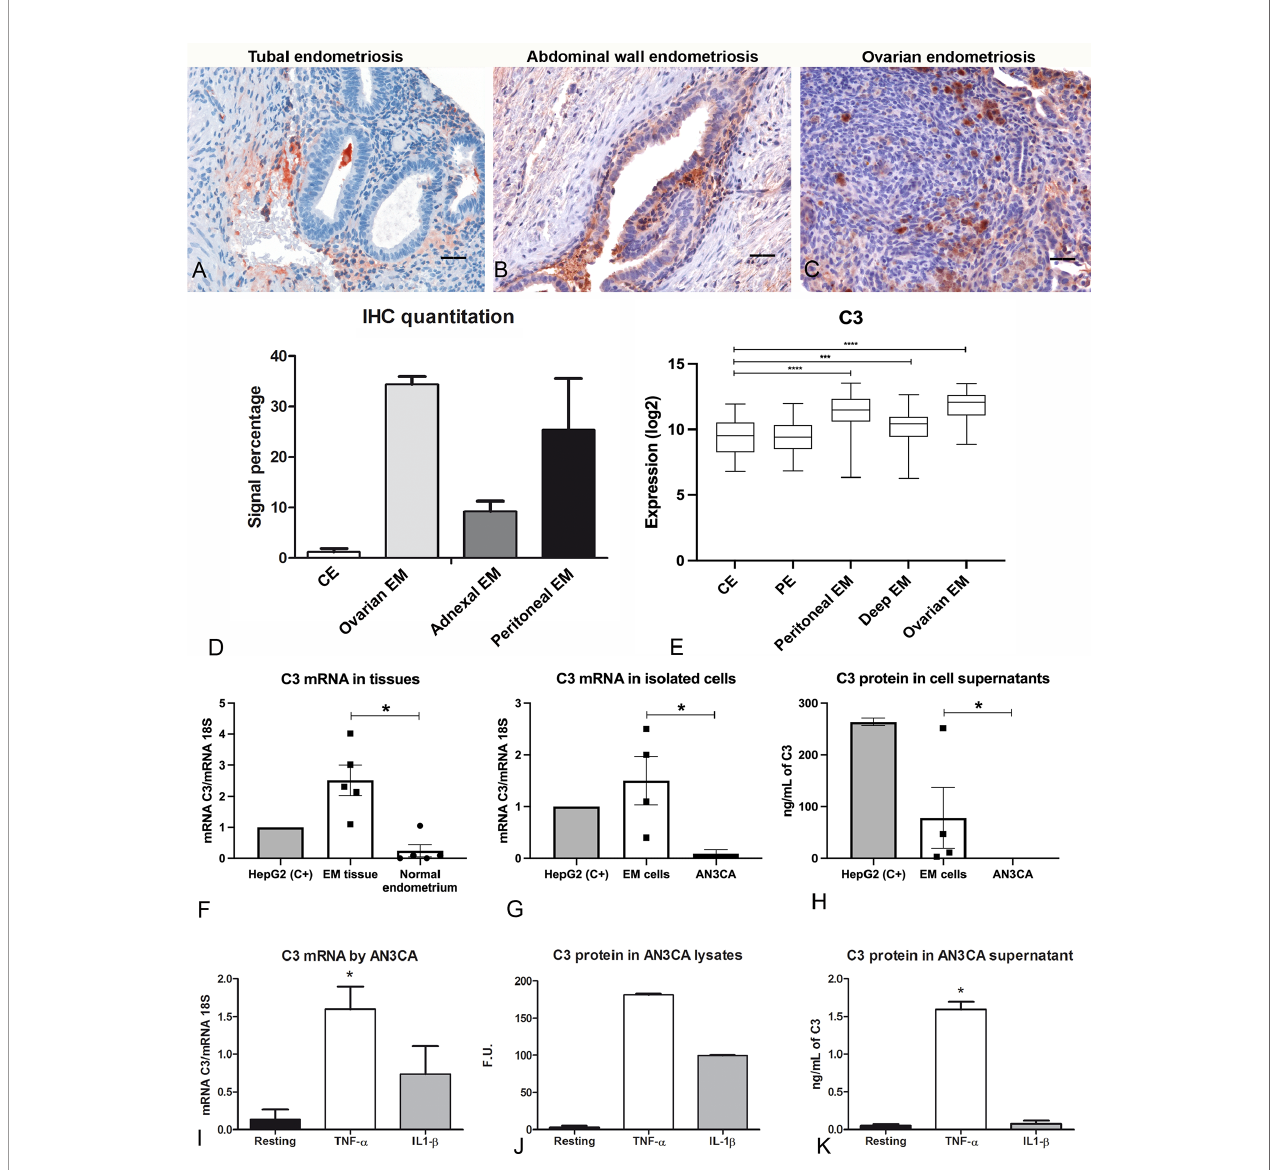
FIGURE 1 | C3 is locally produced in human endometriotic tissue, which is up-regulated by pro-in fl ammatory cytokines. Representative microphotographs showing expression of C3 by IHC in tubal (A) , abdominal wall (B) and ovarian (C) endometriosis (EM). AEC (red) chromogen was used to visualize the binding of anti-human C3 antibodies. Nuclei were counterstained in blue with Harris Hematoxylin; scale bars, 50 m m. (D) Quantitative analyses of C3 IHC staining were carried out by calculating the average percentage of positive signals in fi ve non-overlapping fi elds for each sample (normal endometrium, n=3; ovarian EM, n=3; adnexal EM, n=3; peritoneal EM, n=3) at medium-power magni fi cation (200 x), using the Positive Pixel count v9, ImageScope software, as compared to control endometrium (CE). Data are expressed as mean ± standard deviation. (E) Histogram representing C3 mRNA expression in CE, patient endometrium (PE) and in different EM lesions (peritoneal, deep and ovarian EM). GEP analysis, based on data extracted from GEO (GSE141549), highlighted a signi fi cantly higher expression of C3 in EM lesions as compared to CE. ***p < 0.001, ****p < 0.0001 (Mann-Whitney U Test). (F) The gene expression of C3 by EM tissue (n = 5) was investigated by RT-qPCR and compared to normal endometrium (n= 5) using HepG2 hepatocyte cells as calibrator (AU = 1). 18S was used as the housekeeping gene. Data are expressed as mean of at least three independent experiments ± standard error. *p < 0.05 (Mann-Whitney U Test). (G) The C3 mRNA expression was measured by RT-qPCR in EM cells (n= 4) and compared to a normal endometrial cell line, AN3CA. Data are expressed as mean of at least three independent experiments ± standard error. *p < 0.05 (Mann-Whitney U Test). (H) Protein levels of C3 were assessed by ELISA in the supernatant of EM cells (n=4) or AN3CA maintained in culture for 60 h. Data are expressed as mean at least three independent experiments± standard error. (I) The stimulation of AN3CA cells with pro-in fl ammatory cytokines induced an up-regulation of C3 expression. AN3CA cells were ON stimulated with TNF- a (100 ng/mL) or IL-1 b (5 ng/mL) and the C3 expression was analyzed by RT-qPCR. Data are expressedas mean ofat leastthree independent experiments conductedin duplicate± standard error.*p < 0.05 (Wilcoxon matched pairs test). (J) The expression of C3 was examined incell lysates bywestern blot analysisand the intensity ofthe bandswas measured with Odyssey-LICOR scanner. (K) Measurement of C3 protein